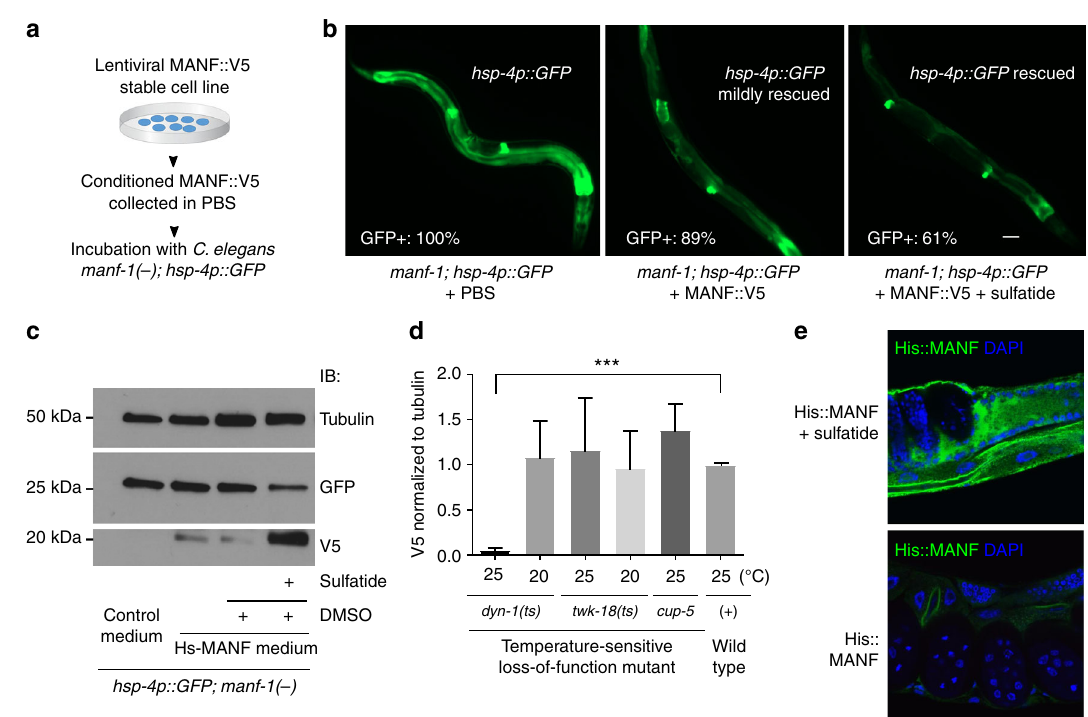
Fig. 3 ER stress-rescuing effects of MANF and sulfatide in C. elegans . a Schematic of experimental work fl ow to test rescuing effects of human MANF from conditioned cell culture PBS. b Exemplar GFP fl uorescence images showing the rescue of the hsp-4p::GFP phenotype in the manf-1 null tm3603 mutant by incubation with puri fi ed MANF secreted from conditioned media. MANF alone rescued only mildly compared with fuller rescue by MANF plus exogenous sulfatide addition (500 µ M in DMSO; sulfatide alone had no rescue), with indicated penetrance of rescue ( N ≥ 100 for each genotype). c Exemplar western blot of Hs-MANF in C. elegans manf-1 mutants after incubating with Hs-MANF, showing sulfatide dependency of endocytosis and rescue of hsp-4 ::GFP levels by endocytosed Hs-MANF. d Normalized levels of Hs-MANF::V5 immunoblot signals (from three biological replicates of N ≥ 100 animals) showing block of Hs-MANF endocytosis in temperature-sensitive endocytosis mutant dyn-1 (ts) cultured from 25 °C but not at the permissive temperature, 20 °C. e Exemplar immuno fl uorescence images of C. elegans tissues stained with anti-His (green) and DAPI (blue) indicating the uptaken His::MANF with sulfatide. Scale bar, 15 µ